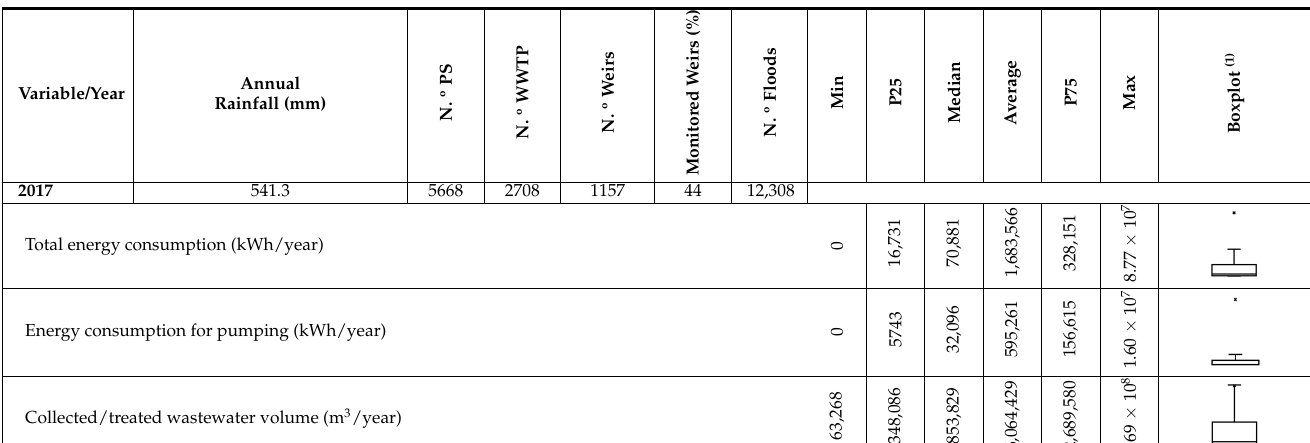
Table A4. National characterization for the evaluation of the W ‐ E ‐ G nexus for 2017.